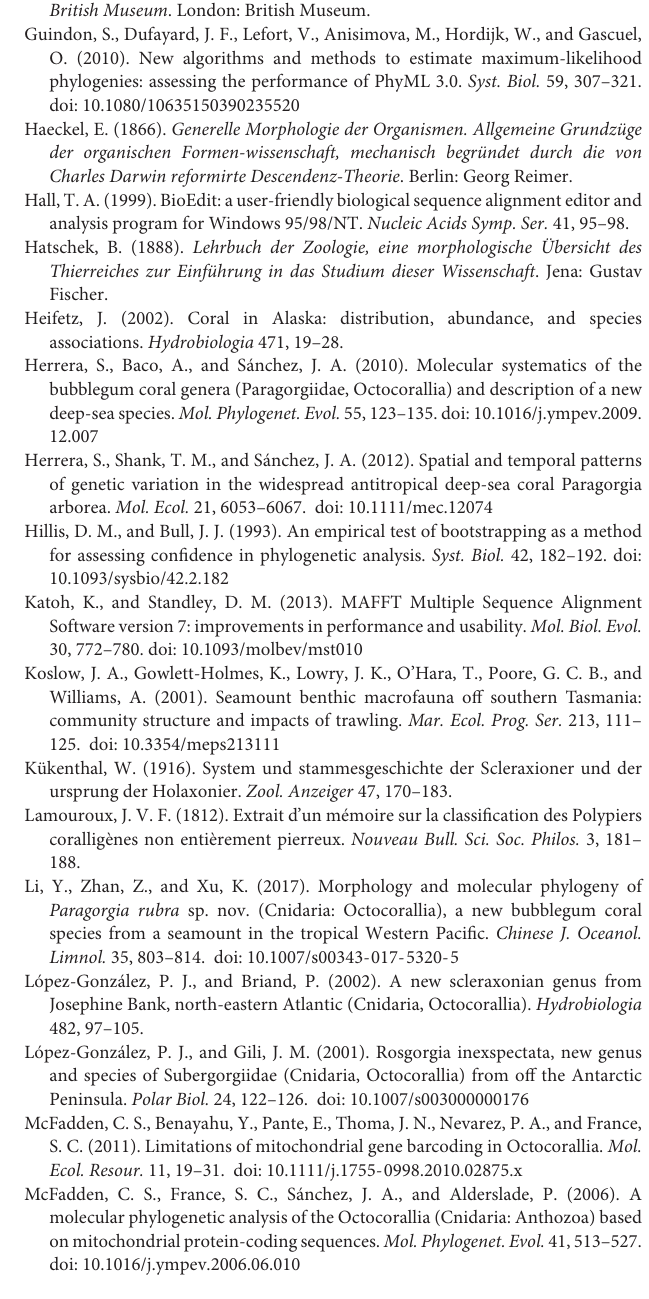
FIGURE S13 | Sclerites from the specimen MBM286392 of Victorgorgia eminens Moore et al., 2017. (A) Sclerites from tentacles. (B) Sclerites from points and collarets. Scale bars = 100 µ m. FIGURE S14 | Sclerites from the specimen MBM286392 of Victorgorgia eminens Moore et al., 2017. (A) Sclerites from calyces. (B) Sclerites from cortex. (C) Sclerites from medulla. Scale bars = 100 µ m. FIGURE S15 | Maximum likelihood (ML) and Bayesian inference (BI) trees based on mtMutS showing phylogenetic relationships among the available Victorgorgia species. Newly sequenced species are in